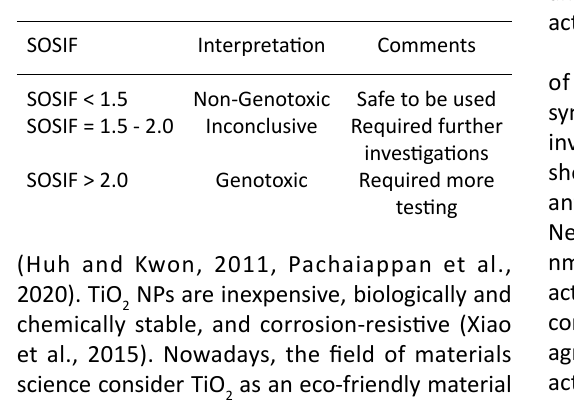
Fig. 8. Antibacterial Activity of TiO and E. coli